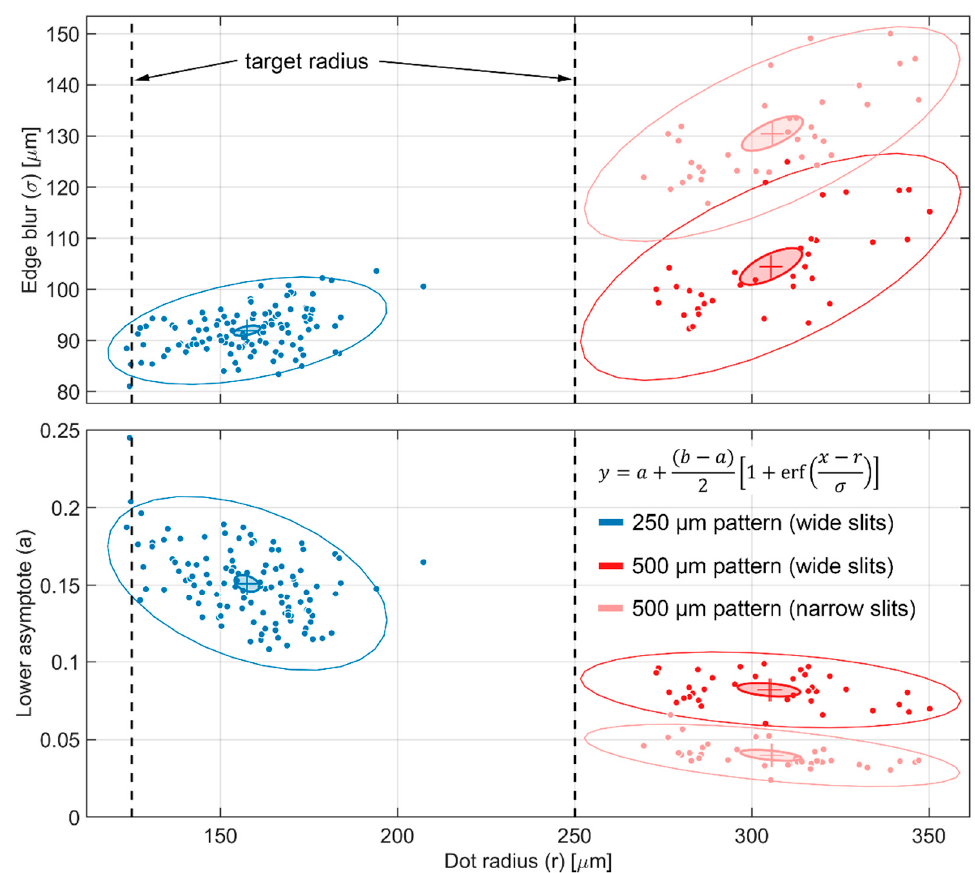
Figure 11. Error function fit statistics for BB dots imaged at CG-1D.